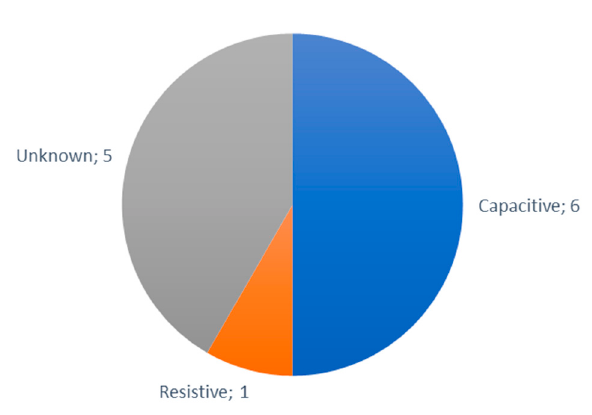
Figure 18. Most utilized humidity sensors by type.